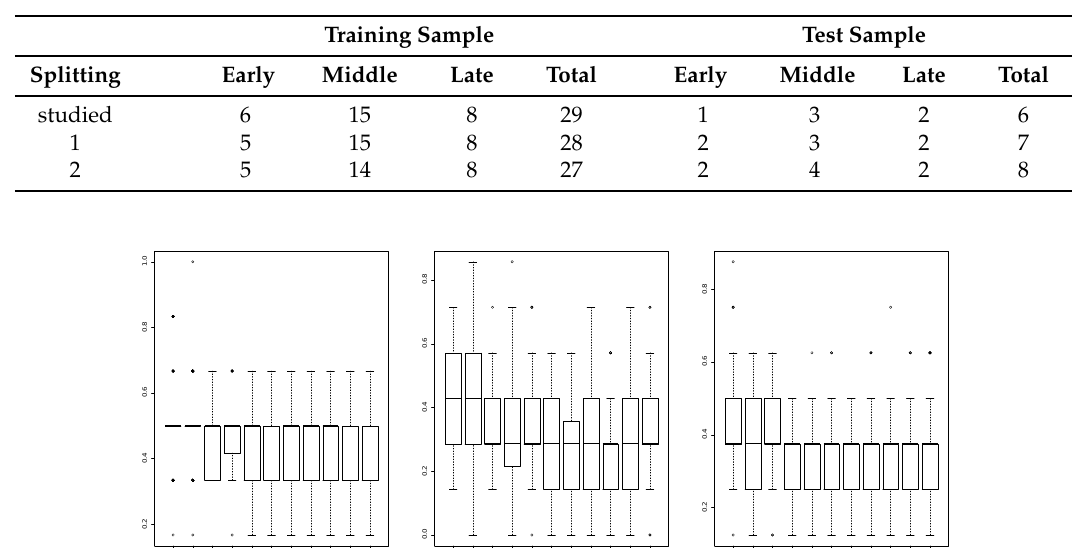
Table 3. Stages of the patients selected in the training and test sample for each of the performed splittings.